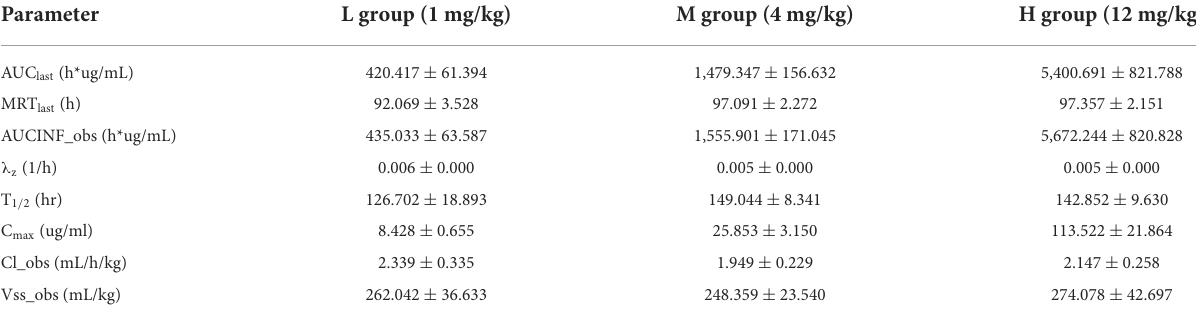
TABLE 4 Summary of pharmacokinetic parameters (mean ± SD) for the recombinant canine PD-1 fusion protein in canines following IV infusion administrations.